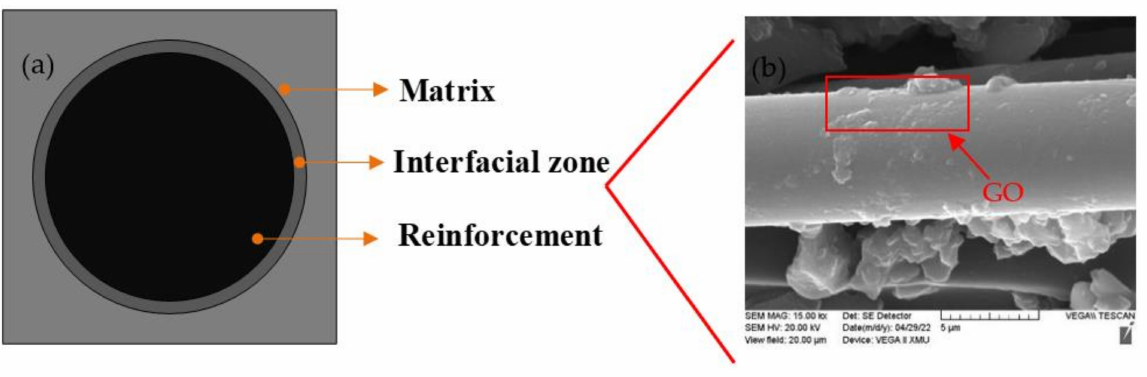
Figure 7. Schematic diagram of the three-phase model. ( a ) Three-phase model; ( b ) Mechanical locking